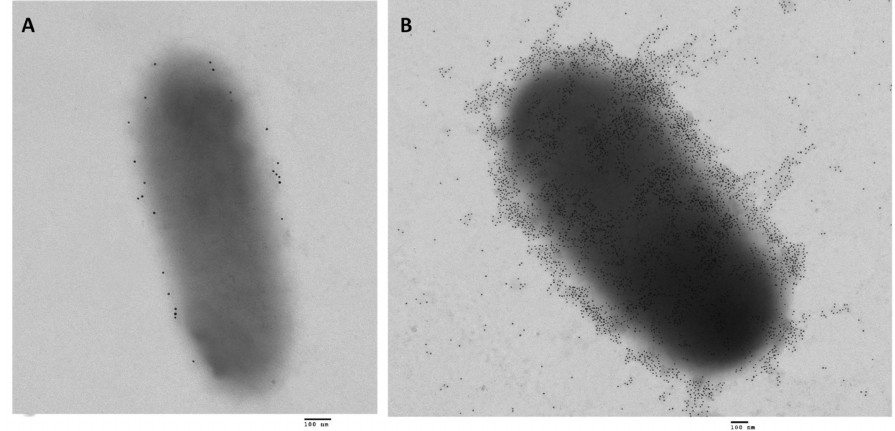
Figure 5. Transmission electron micrographs of E. coli BL21 expressing the Sha autotransporter [31] immunolabelled with 10-nm-diameter gold particles ( A ) The negative control, adsorbed serum was used for the primary incubation with E. coli BL21 empty vector and shows very low background of gold particles. ( B ) Gold-labelling with AT-specific antibodies shows that when Sha is constitutively expressed, proteins are localized on the surface as well as released in the supernatant. So, the protein released can gain access to host cell targets, whereas the protein associated with bacterial cells can mediate agglutination, autoaggregation, and adherence to host cells. Bar 100